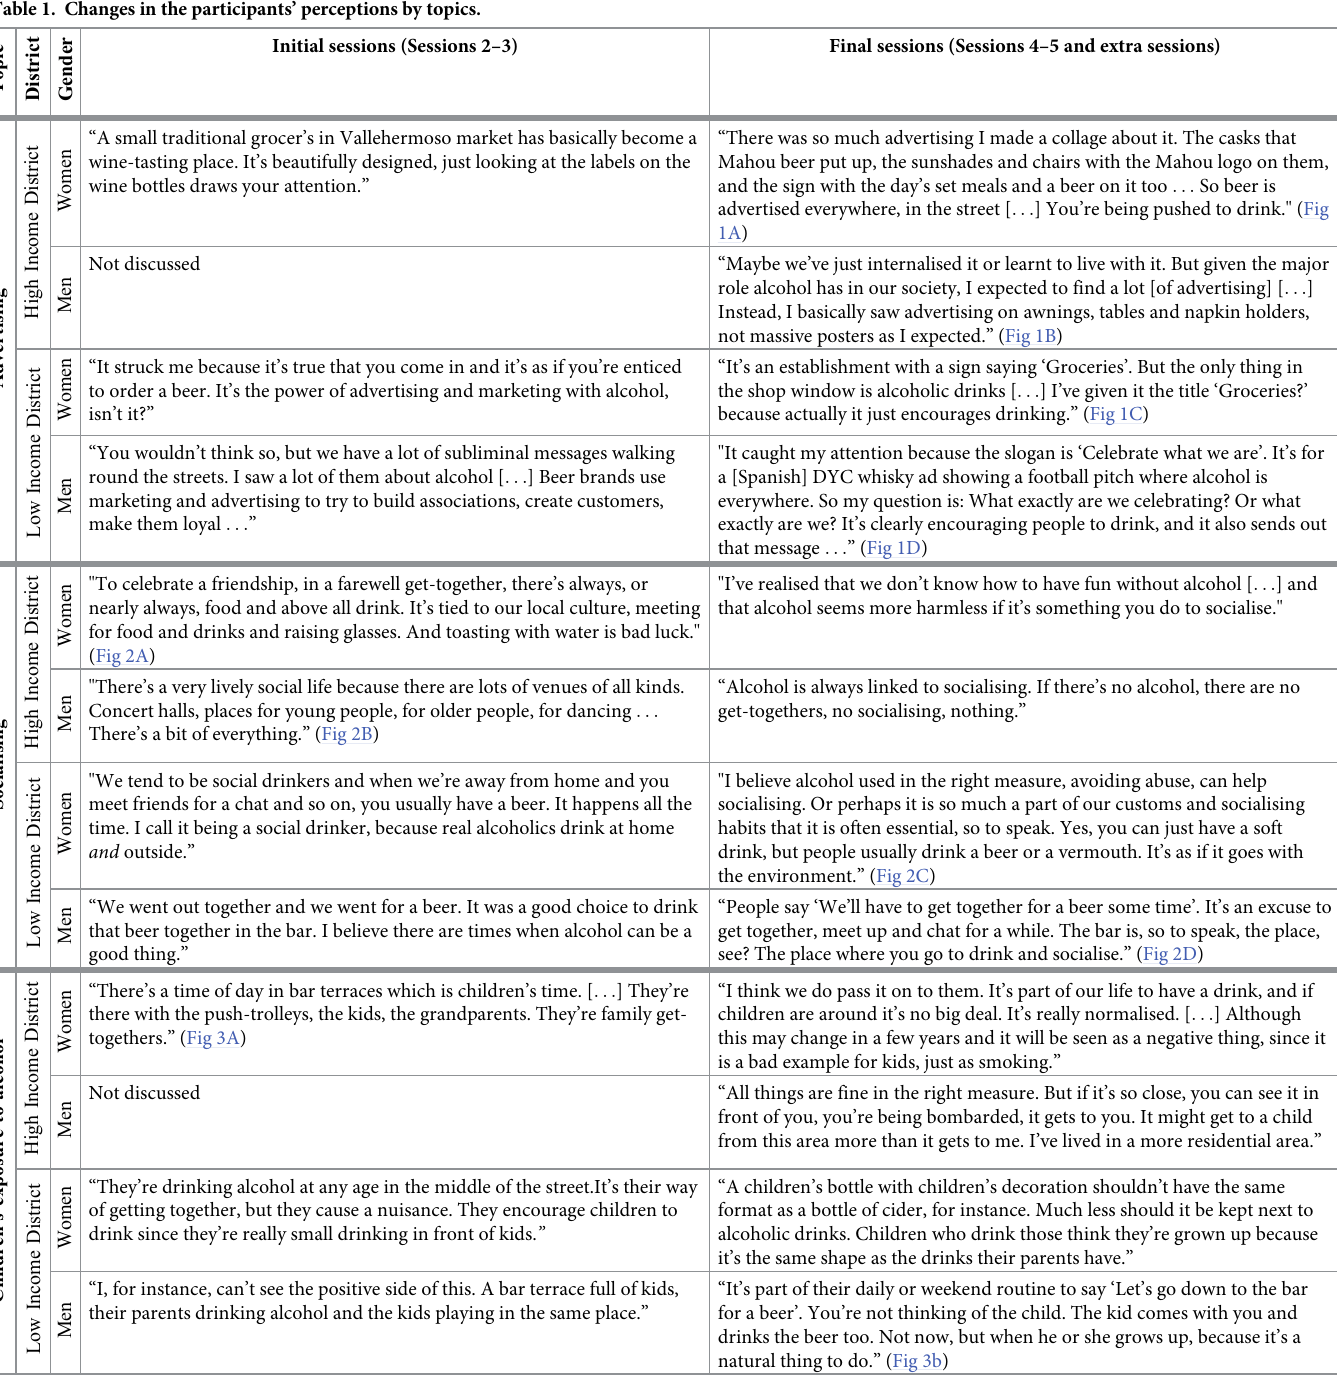
Table 1. Changes in the participants’ perceptions by